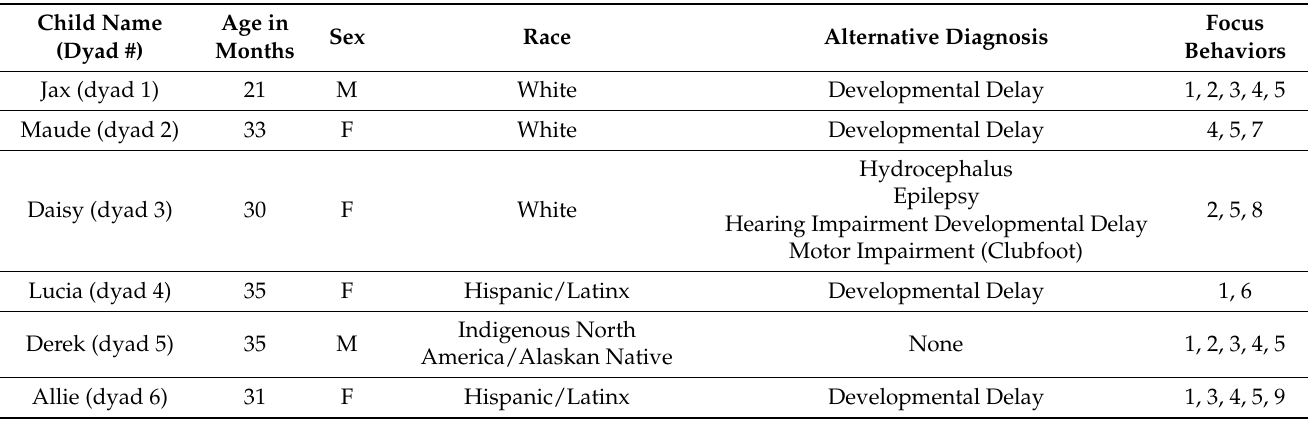
Table 1. Child Participant Characteristics.